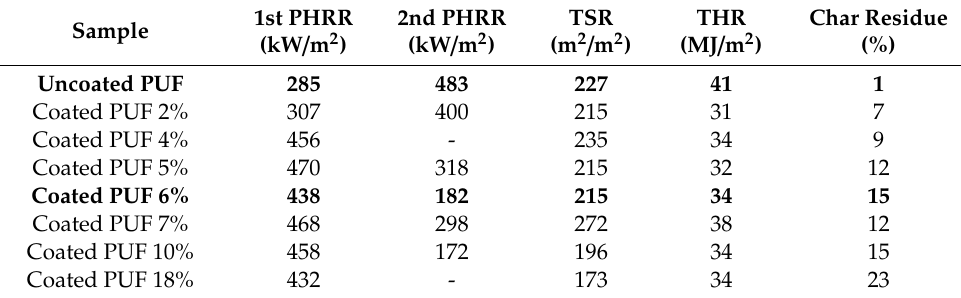
Figure 20. ( a ) and ( b ) Heat release rate plotted versus time for uncoated and coated PUF. Table 4. Cone calorimetry results of uncoated and coated PUF.